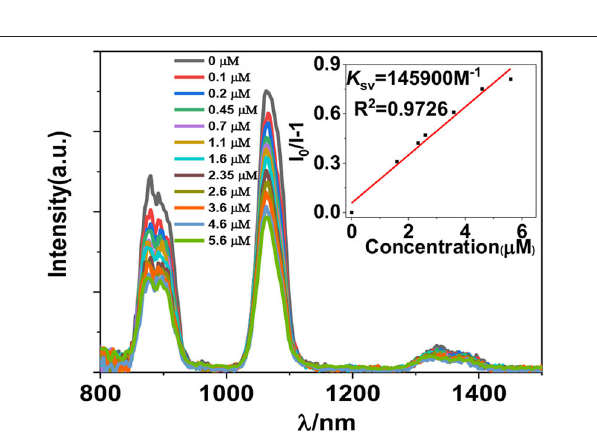
shows typical NIR luminescence of Nd 3 + ( 4 F 3 / 2 → 4 I j / 2 transitions, j = 9, 11, and 13), and the most intense line is at 1,054 nm ( 4 F 3 / 2 → 4 I 11 / 2 ) ( Figure 3 ). The complex exhibits